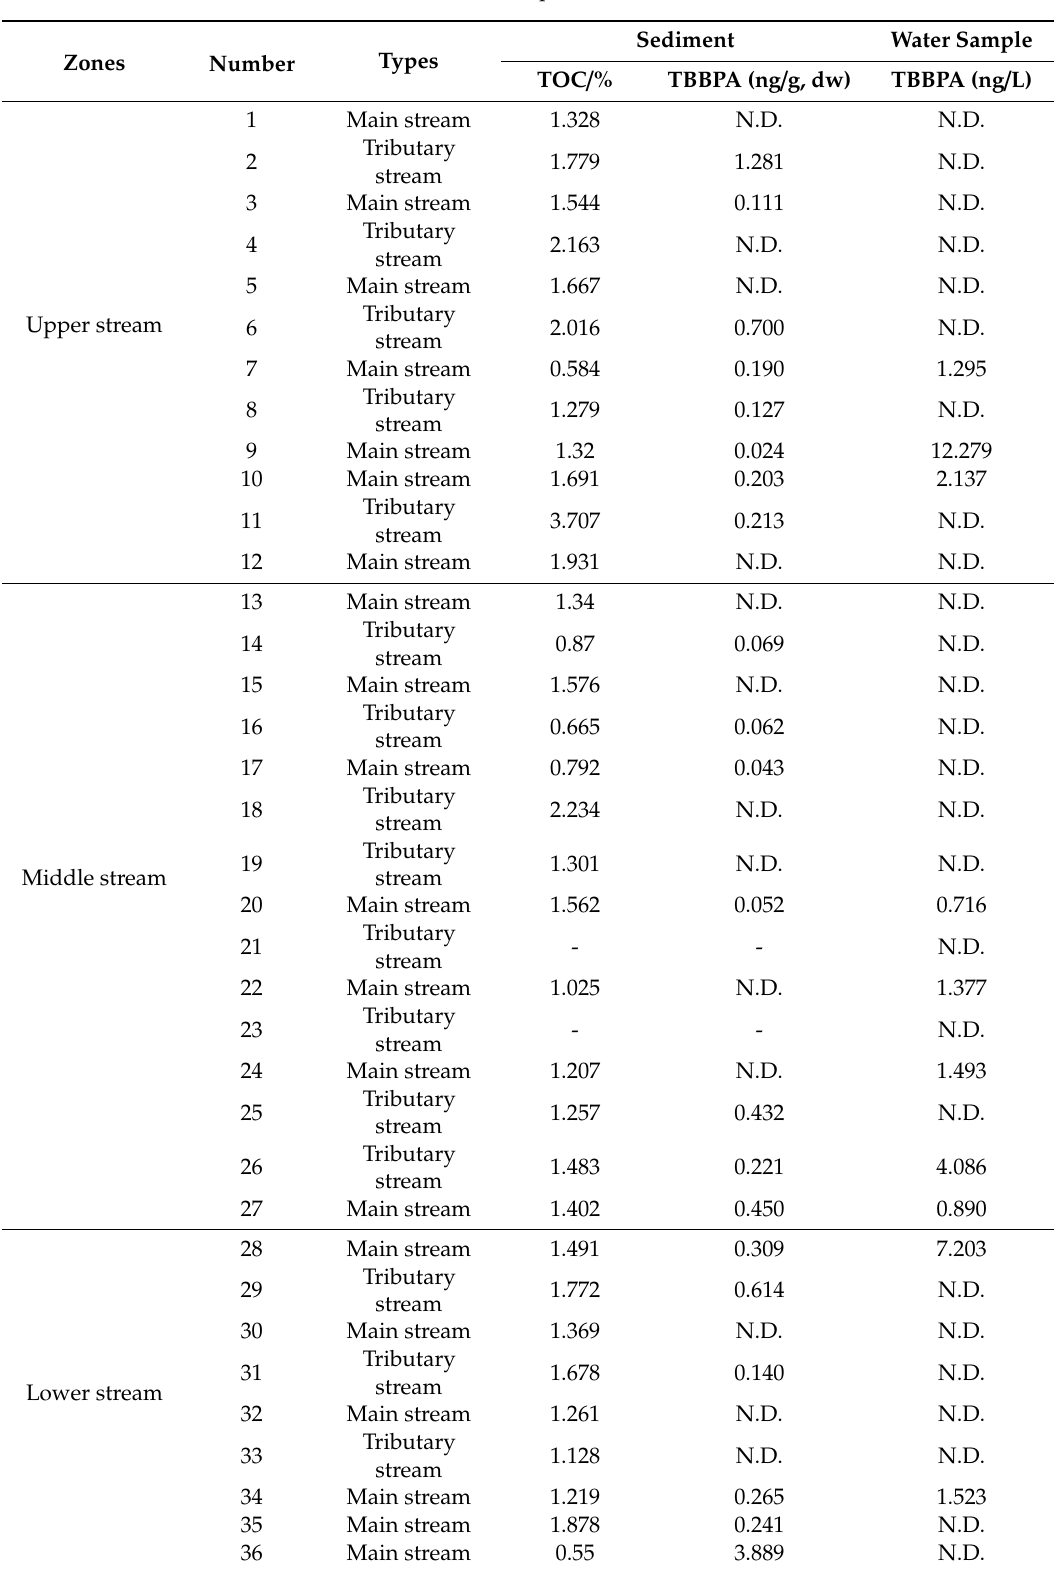
Table 1. Residue levels of tetrabromobisphenol A (TBBPA) in the Weihe River. Zones Number Types